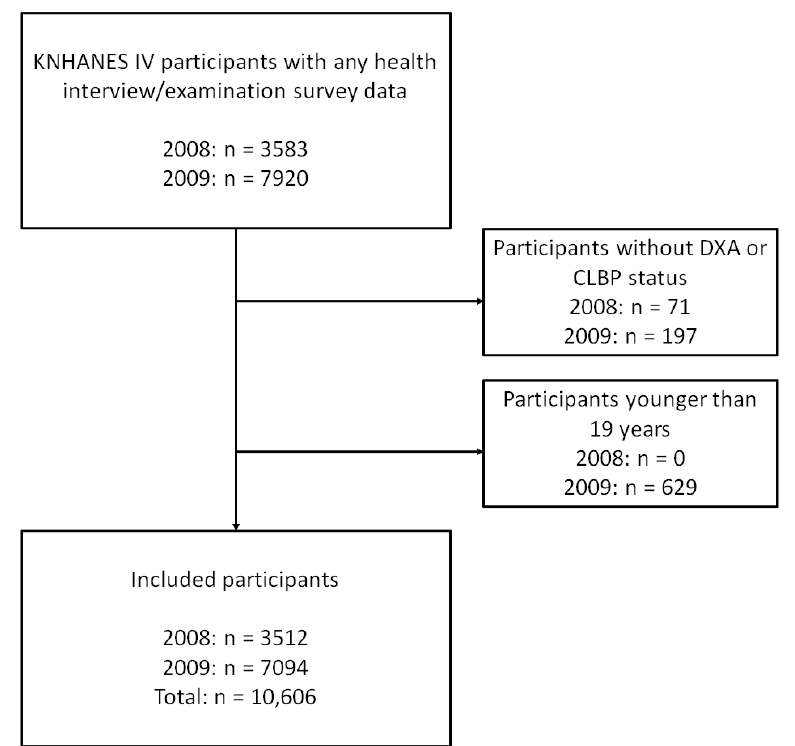
Figure 1. Flow chart of participant enrollment. Abbreviations: KNHANES, Korean National Health and Nutrition Examination Survey; DXA, dual-energy X-ray absorptiometry; CLBP, chronic low back pain.